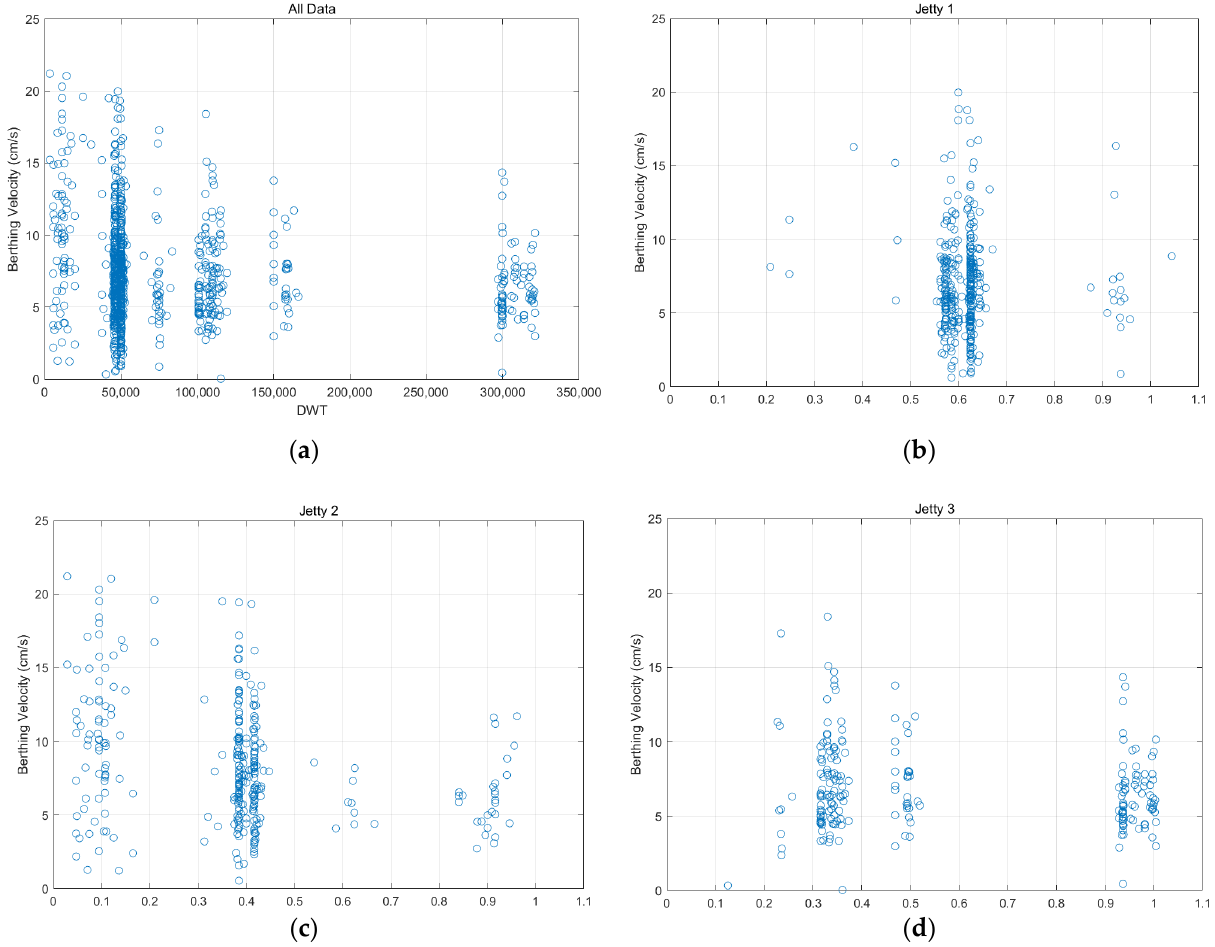
Figure 7. The berthing ship size by nondimensionalization of the ship size compared with the berthing capacity of each jetty: ( a ) scatter plot of all data and ( b – d ) nondimensionalization of ship size in Jetties 1–3, respectively.